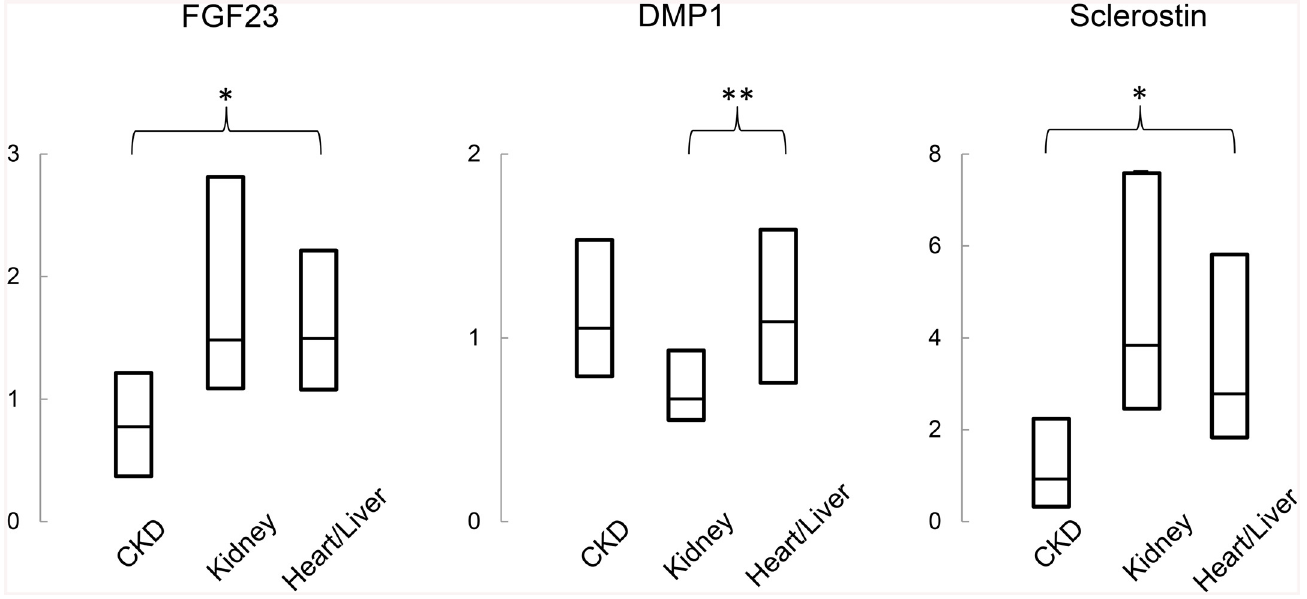
Fig 2. Quantification of bone (A) FGF23; (B) DMP1 and (C) sclerostin expression in non-transplant CKD patients, kidney transplant recipients, and liver or heart transplant recipients. The asterisk represents a difference between allograft recipients and non-transplant CKD patients; the double asterisk represents a difference between kidney and heart or liver allograft